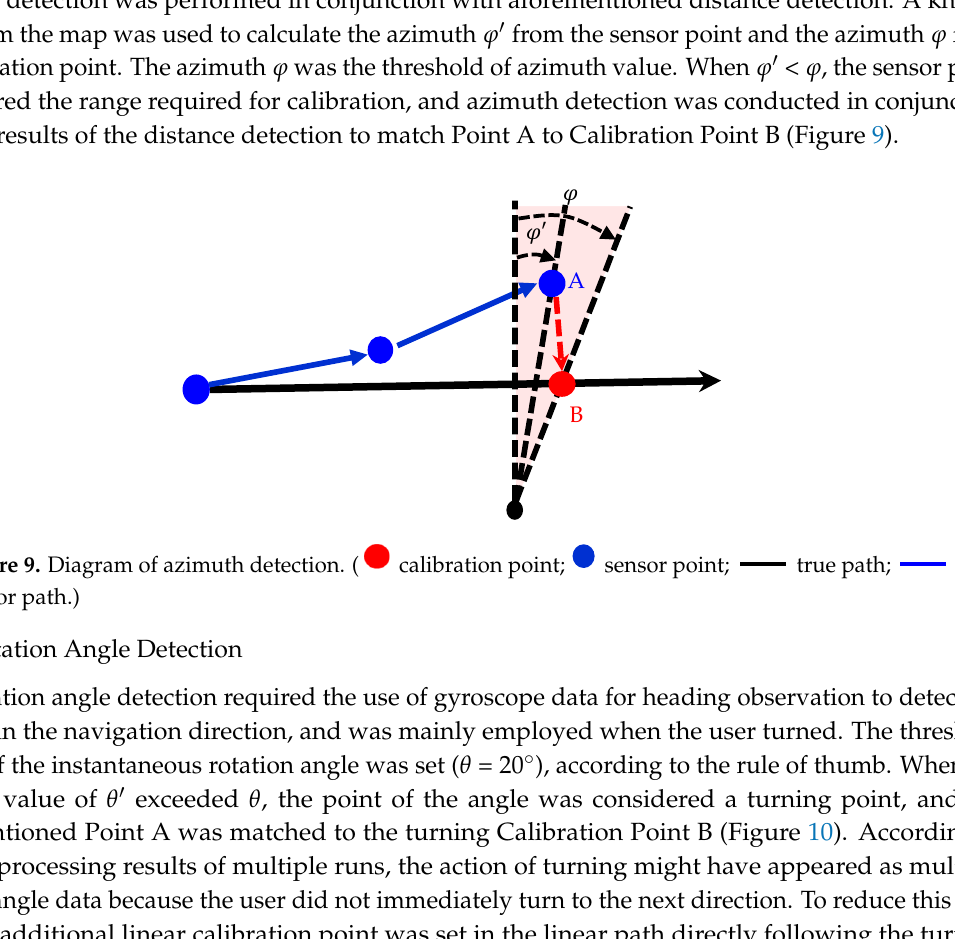
Table 3. Basic Attributes of the Fields.